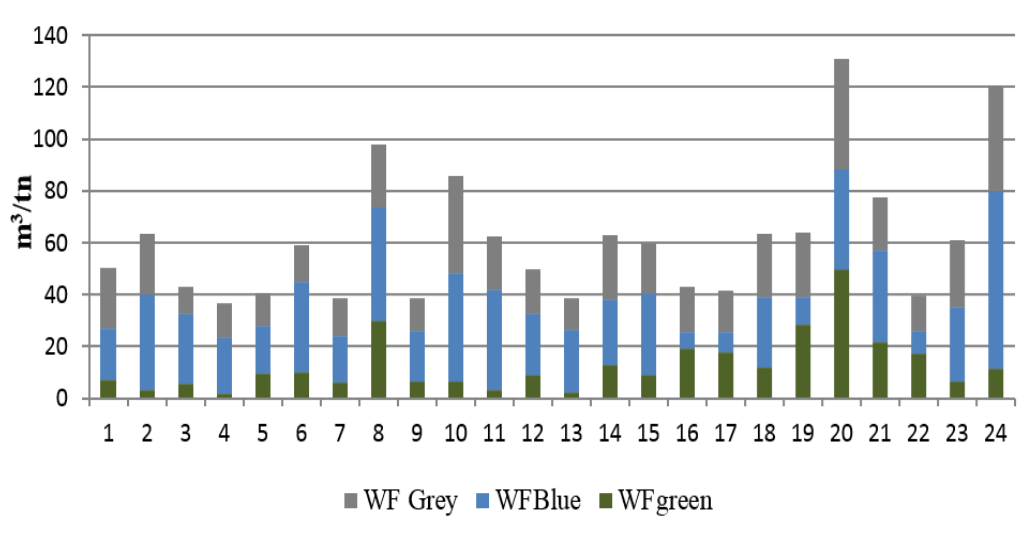
Figure 2. Grey, Blue and Green Water Footprint of the 24 farms in the Pinios River Basin. Figure 3. Grey, Blue and Green Water Footprint of the 24 farms in the Pinios River